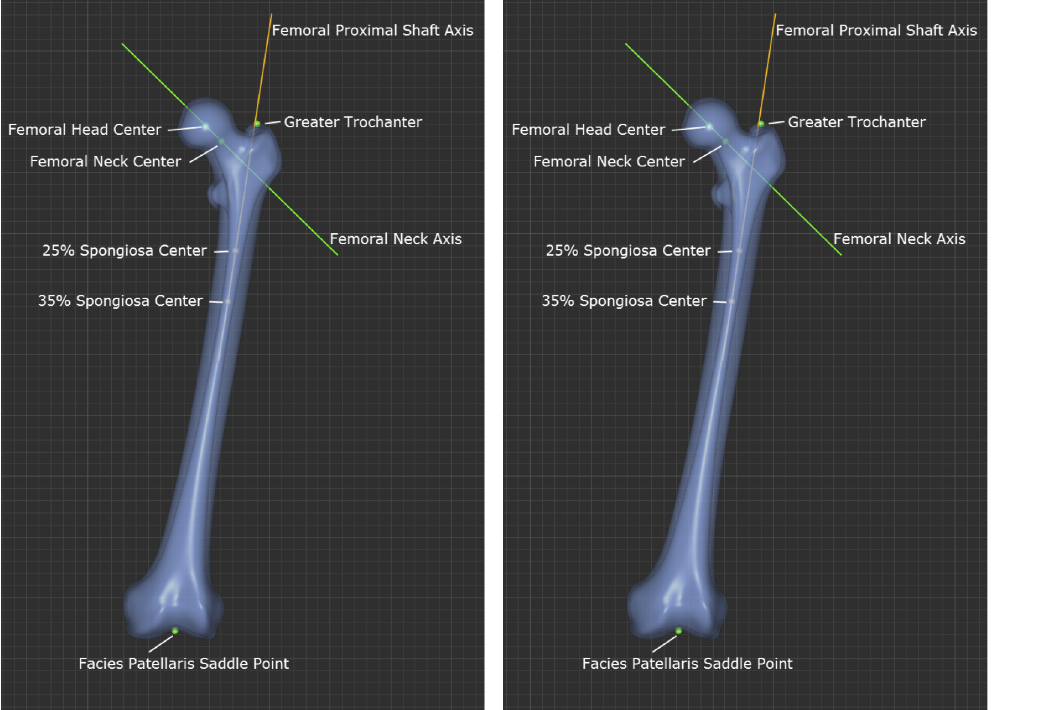
Fig 1. Fig 1 shows the definition of “ femoral proximal shaft axis ” and “ femoral neck axis ” with (a) AP View, (b) LM